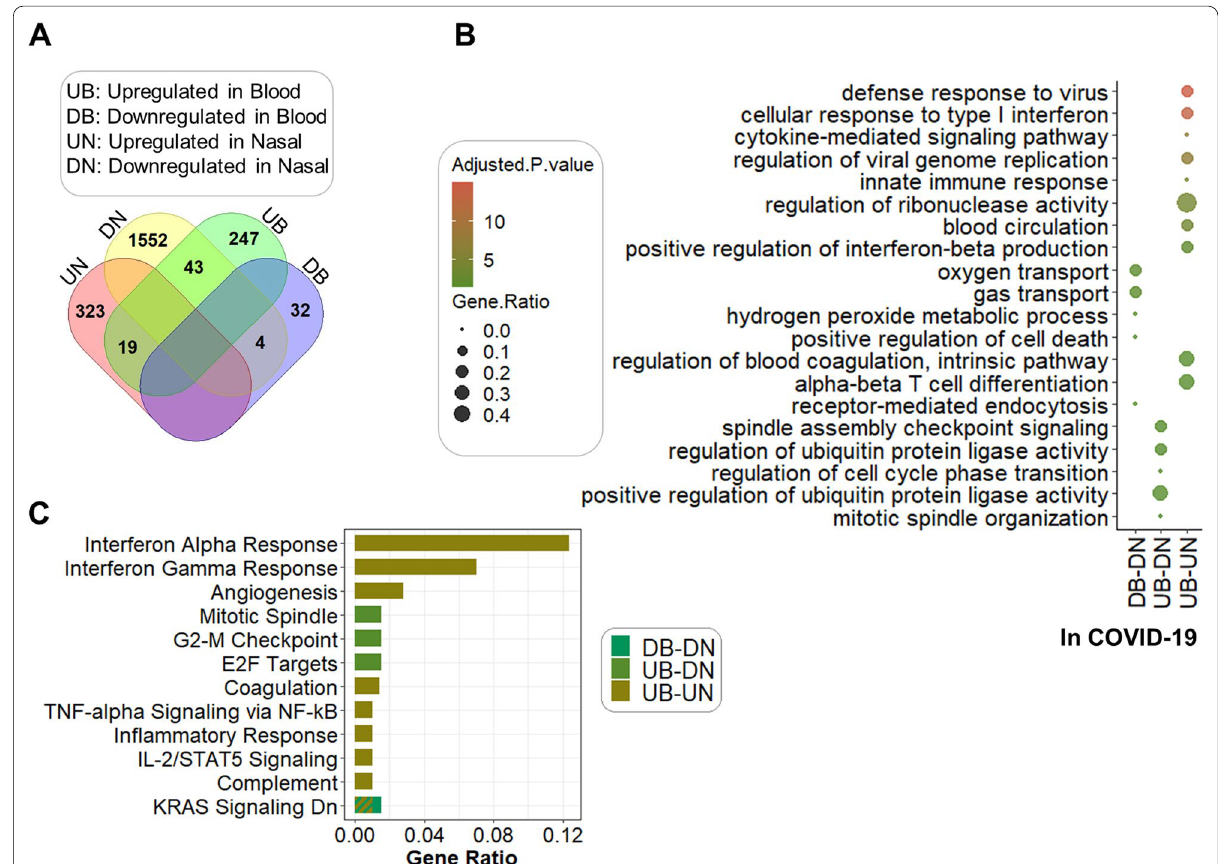
Fig. 5 Analysis of common dysregulated genes in SARS-COV-2 -infected whole blood and nasopharyngeal samples in comparison with healthy controls: The Venn diagram to display the distribution of genes in four desired groups ( UB upregulated genes in blood, DB downregulated genes in blood, UN upregulated genes in nasal, and DN downregulated genes in nasal) ( A ). Dot plot to show BPs according to common genes of each paired group. The size of the dots is proportional to the gene ratio in considering process and the color corresponds to the –log10 of the adjusted P-value. Selected top and not-redundant terms are visualized ( B ). Bar plot to depict hallmark gene set enrichment analysis. The size of the bars is proportional to the gene ratio in considering pathway and the color corresponds to paired groups whose common genes were studied. The “KRAS Signaling Dn” pathway was enriched in two groups ( C ). BP biological